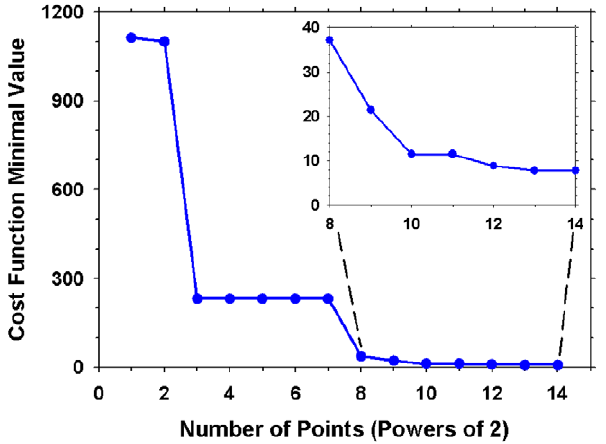
Figure 3. Convergence of the minimum value of the empirical cost function with the number of Sobol points.